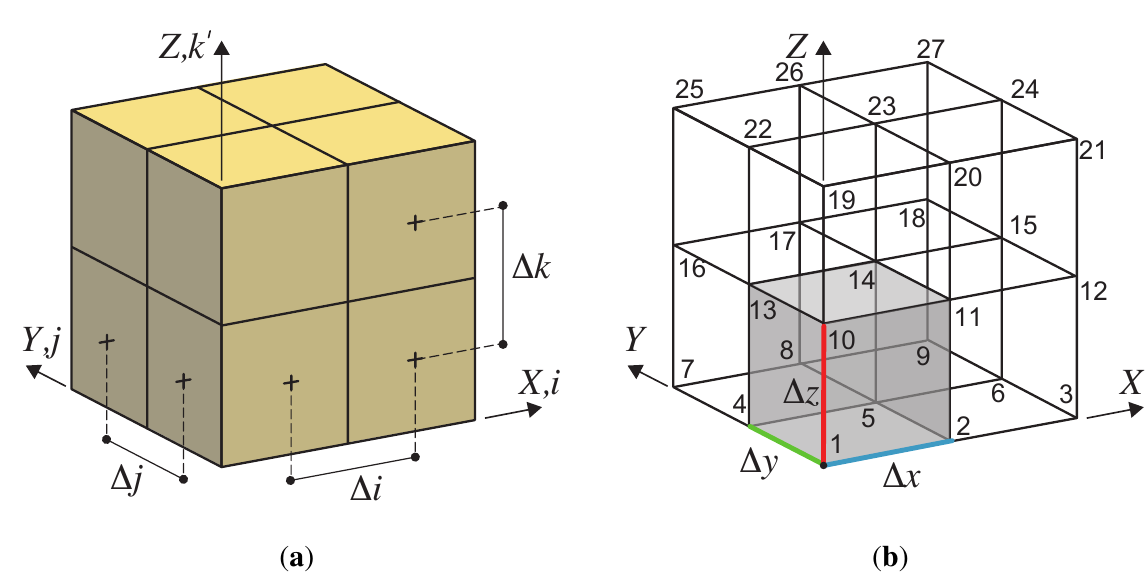
i, j, k X, Y, Z and { } { }